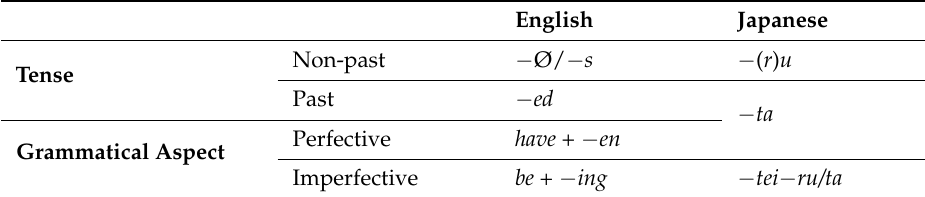
Table 2. Tense-aspect morphology in English and Japanese.